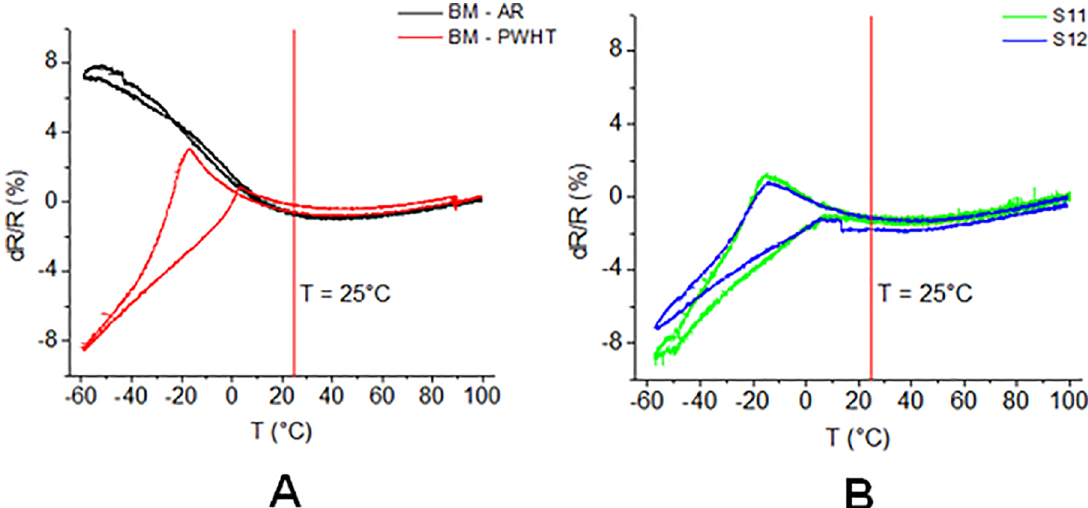
Figure 5. ERT curve of (a) NiTi base metal and (b) similar welded